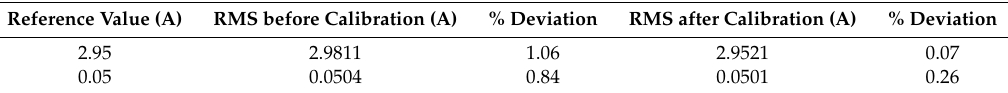
Table 2. Current Calibration Results.